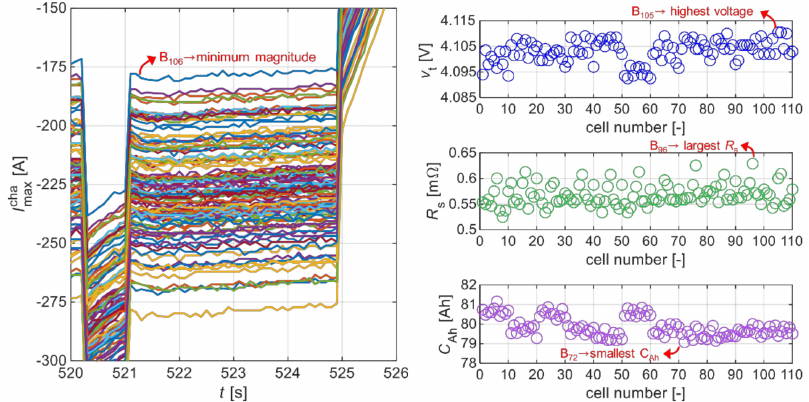
Figure 5. Enlarged waveform of I cha max and the inconsistency of v t , R s , and C Ah at a time point of 521.0